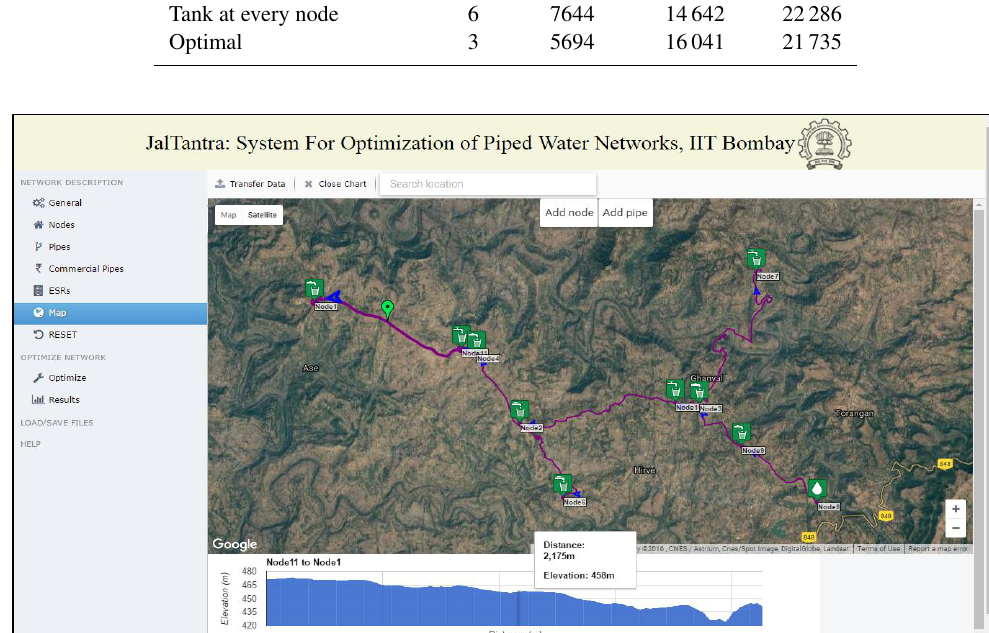
Figure 2. Sample network marked in